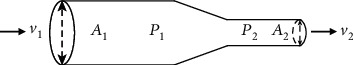
Air flows through a channel with different sizes.